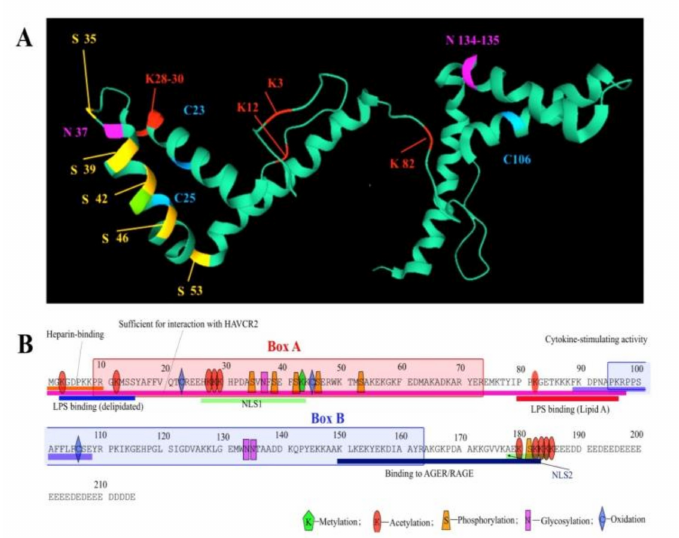
Figure 2. The post-translational modifications of HmgB1. ( A ) The 3D orientation of modified amino acids of HMGB domains of protein; ( B ) Schematic representation of the location of HmgB1 modification sites and functionally significant sections of the amino acid sequence of HmgB1. HAVCR2—Hepatitis A virus cellular receptor 2; LPS—lipopolysaccharide; AGER / RAGE—advanced glycosylation end-product specific receptor; NLS—nuclear localization sequence. The figure is based on PDB (1AAB, 2GZK) and the data are described in the following works